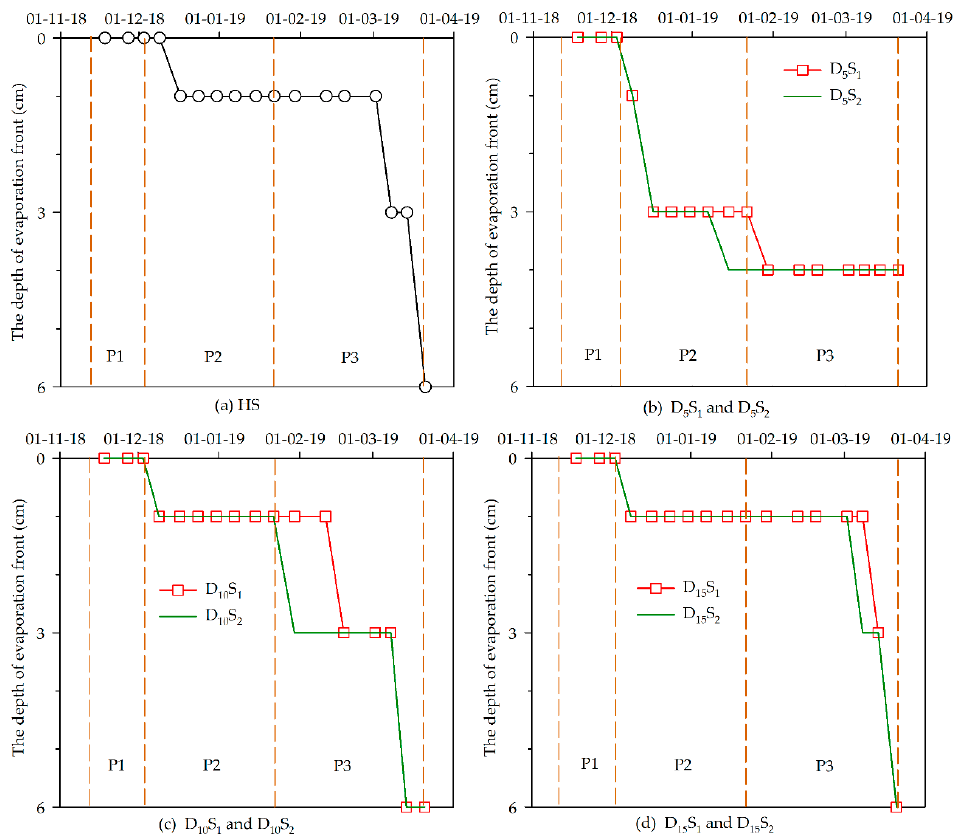
Figure 6. The positions of evaporation fronts in the ( a ) homogeneous soil column; ( b ) sand layer with particle size between 0.5–1.5 mm and 2.0–2.5 mm embedded at 5 cm depths; ( c ) sand layer with particle size between 0.5–1.5 mm and 2.0–2.5 mm embedded at 10 cm depths; ( d ) sand layer with particle size between 0.5–1.5 mm and 2.0–2.5 mm embedded at 15 cm depths in the seasonal freeze–thaw period.